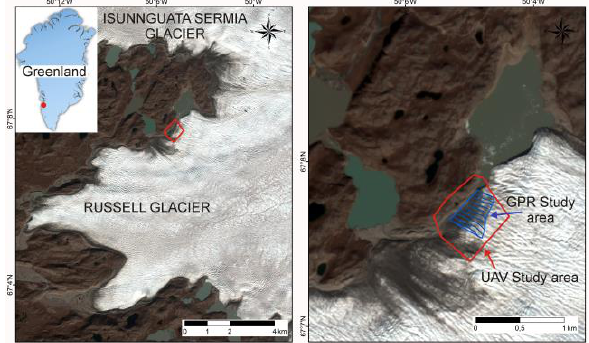
Figure 1. The location of the study area. © Sentinel Image